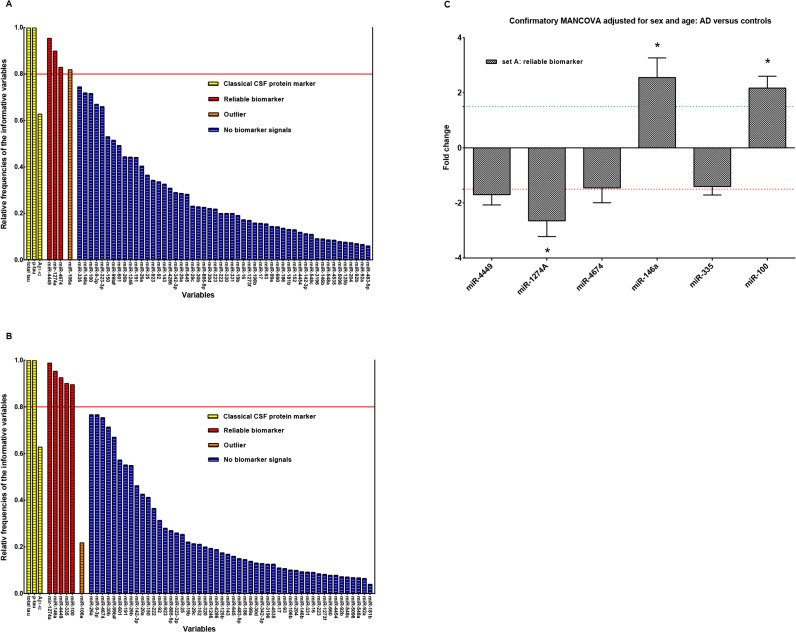
Reliability investigation.Plot of relative frequencies denoting for a miRNA how often among 800 MoR repeats with random subsamples of the original groups it has been crystallized as informative (original groups: controls n = 28, AD n = 22 subjects). (A) Relative frequencies of set A miRNAs with reliable biomarker candidates over the solid red line (RF = 0.8); (B) Relative frequencies of set A miRNAs with reliable biomarker candidates over the solid red line (RF = 0.8) after substitution by corresponding group means; (C) Bar diagram of the reliable biomarker signals of set A. Stars (*) over the bars point to significant p-values (MANCOVA, p < α*, where α* is Bonferroni corrected α = 0.05) and therewith to significant biomarkers.